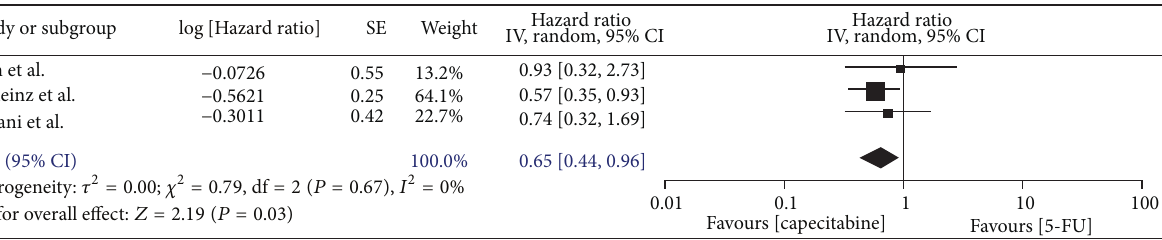
Figure 7: Forest plot of hazard ratio (HR) for 3-year disease-free